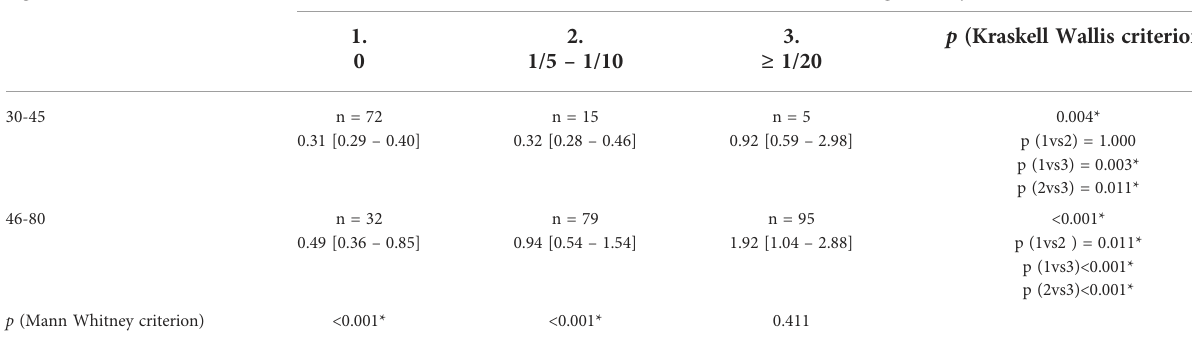
TABLE 4 Median trends in the number of antibodies to orthopoxviruses (ODrel, Me[IQR]) depending on age and VNA.